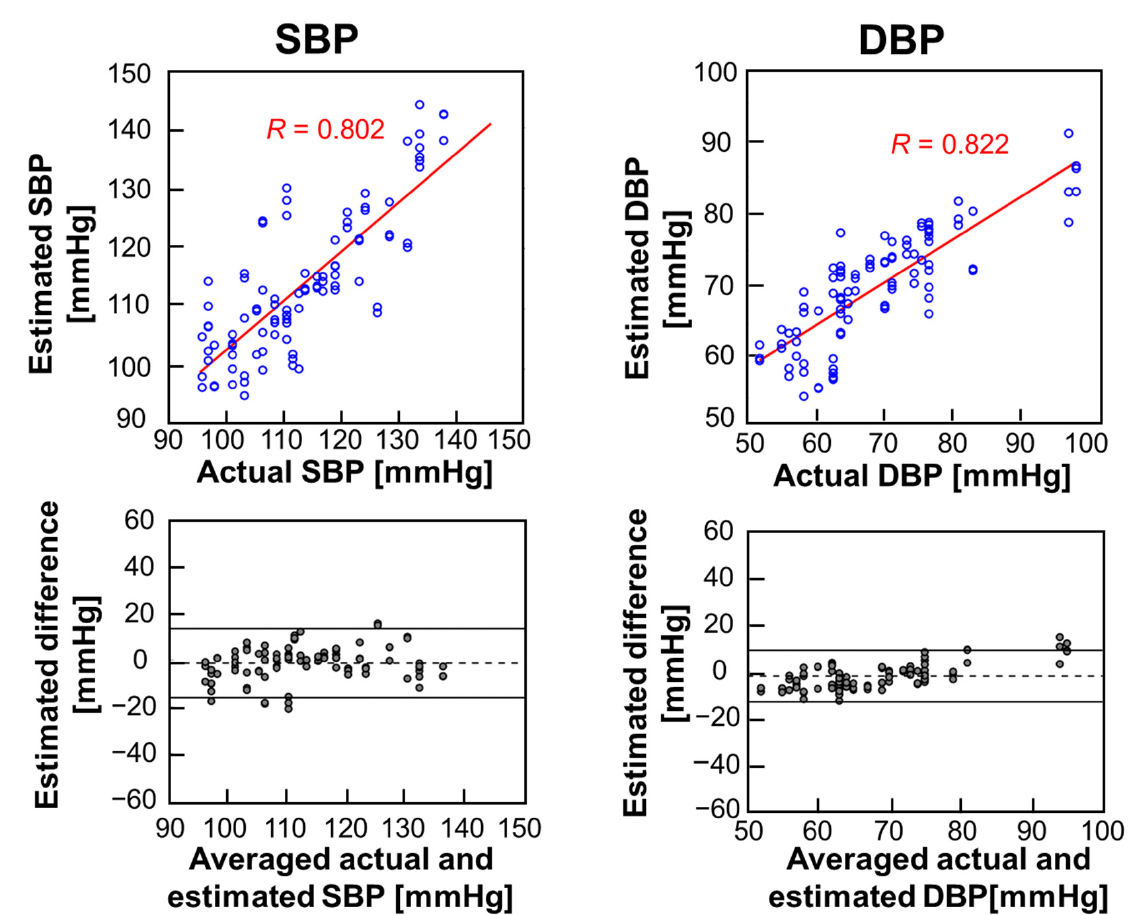
Figure 8. The correlation coefficient and Bland − Altman plot for ∆ BP between actual BP and BP estimation with calibration. The SBP measurement with calibration showed excellent correlation ( r -value = 0.802 and its associated p = 1.18 × 10 − 22 ), with a mean ∆ BP of − 1.373 mmHg (CI = − 16.08 to 13.33) between the actual BP and the estimated BP. The DBP measurement with calibration also showed excellent correlation ( r -value = 0.822 and its associated p = 9.91 × 10 − 25 ), with a mean ∆ BP of − 1.864 mmHg (CI = − 12.88 to 9.15) between the actual BP measurement and the estimated